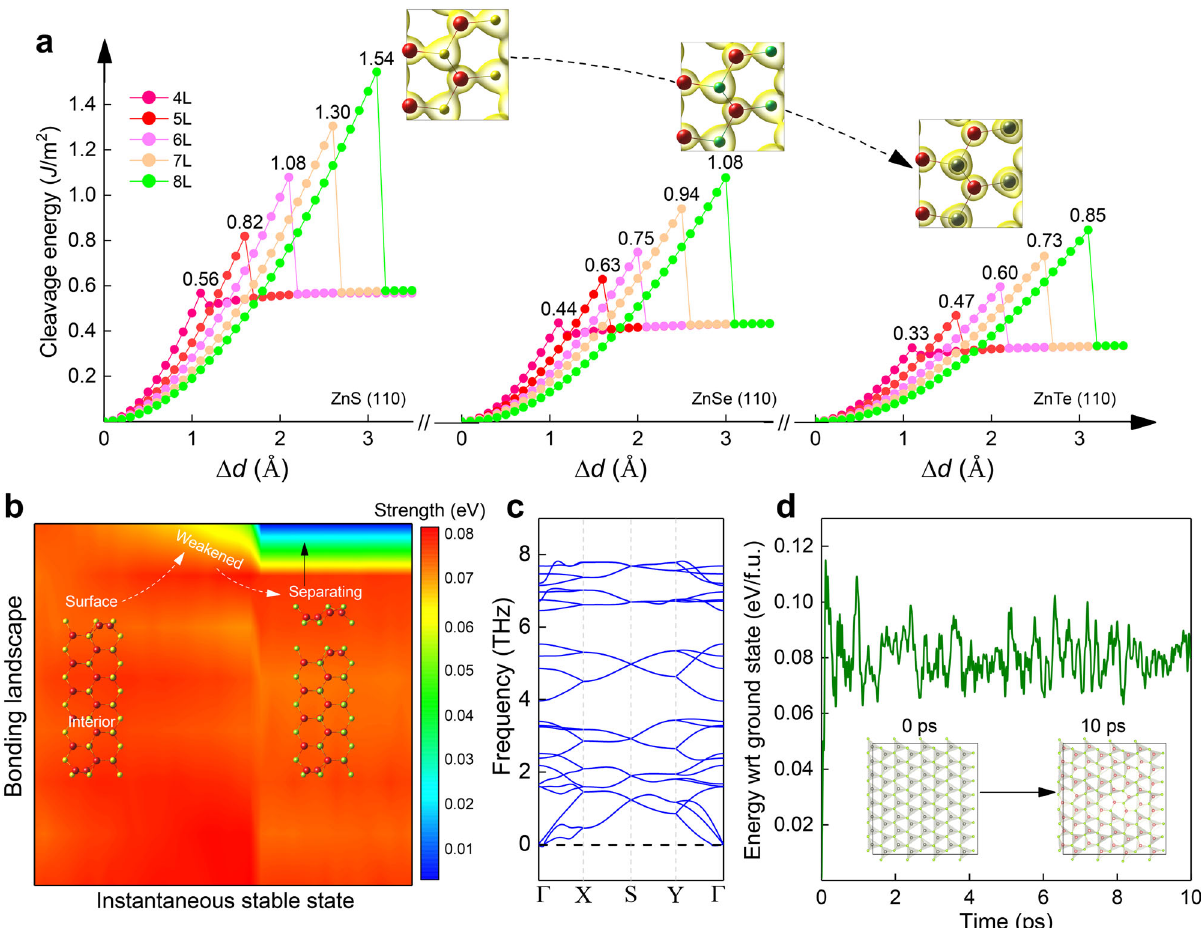
Fig. 2 Cleavage process and stability assessment for the wz monolayers. a Cleavage process for (110) plane monolayer ZnX (X = S, Se, Te) with layer thickness from 4L to 8L, which indicates the monotonically increasing cleavage energy with layer thickness and that the energy drops dramatically at the moment of cleaving off due to the interface reconstruction. The inset shows the gradually localized charge ( ρ = 0.065 eÅ − 3 ) from S to Te for ZnX. b Atomic bonding landscape from interior to surface for 6L (12 atomic-thickness) ZnSe, which indicates the weakened surface bonding strength with gradually stretching until the separation of the outermost layer. c, d Phonon spectrum and AIMD simulation for monolayer ZnSe, which suggests that the monolayer structure is stable with non-imaginary frequency phonon dispersion and no phase